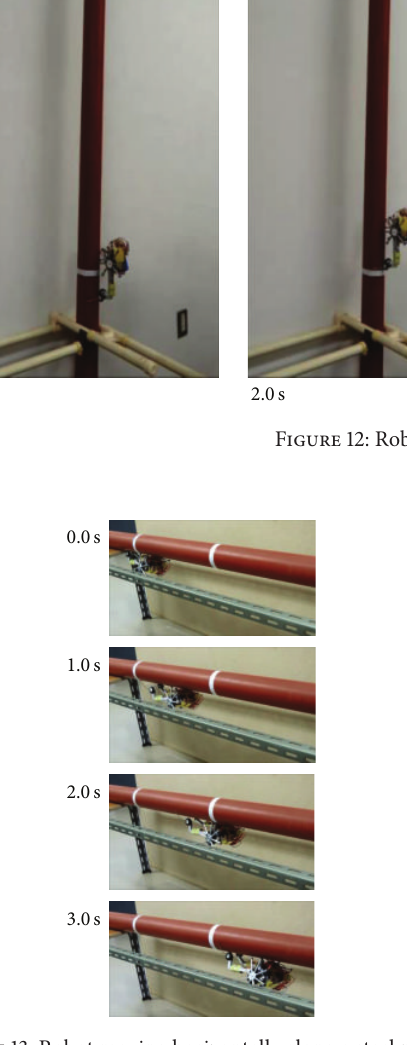
Figure 13: Robot moving horizontally along a steel